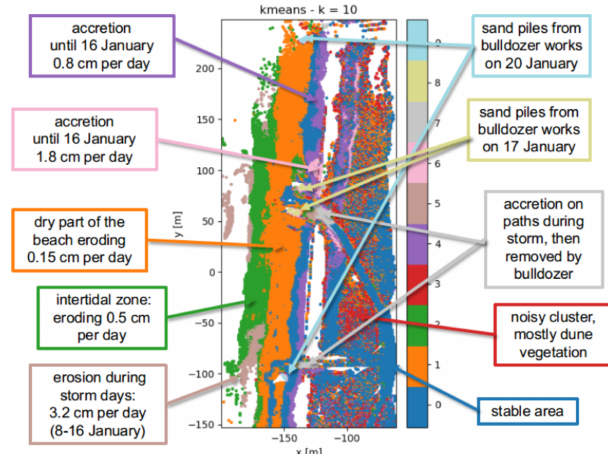
Figure 10. Observation area partitioned into clusters by the k - means algorithm with k = 10. The associated processes are anno- tated with the corresponding